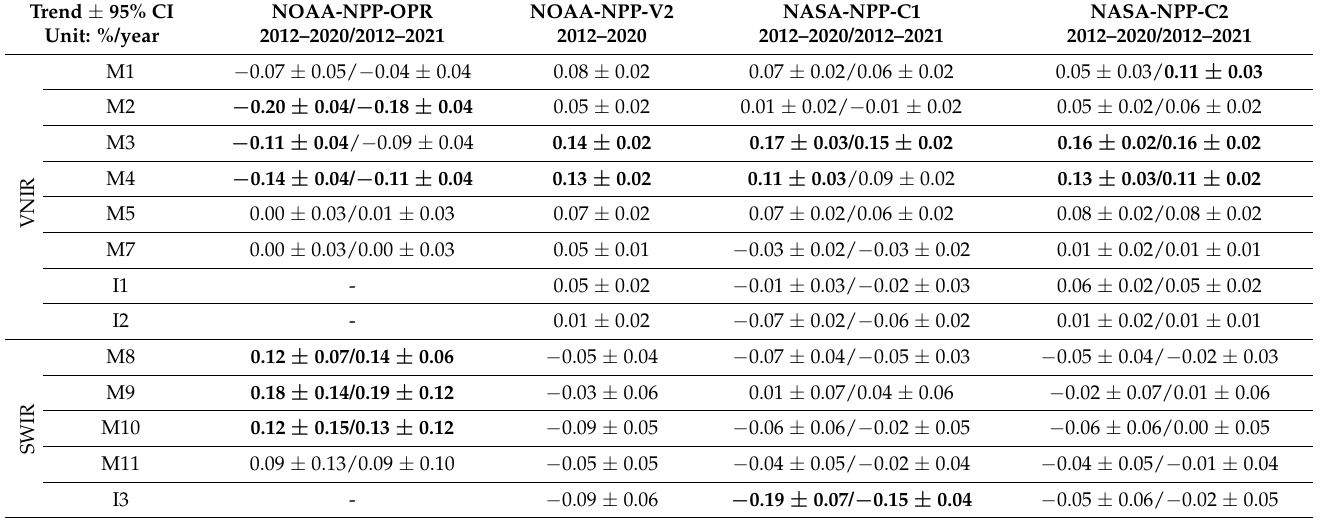
Table 3. Summary of the trends and 95% confidence intervals (CI) of S-NPP VIIRS RSB SDRs generated by NOAA and NASA. Cases with trends larger than 0.1%/year are in